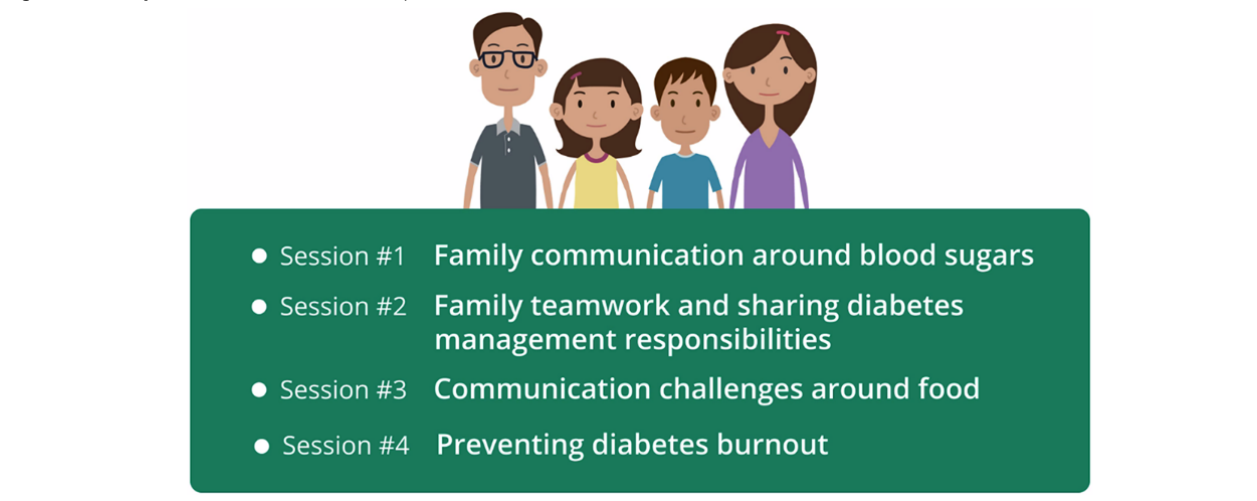
Figure 2. Family Teamwork Online module